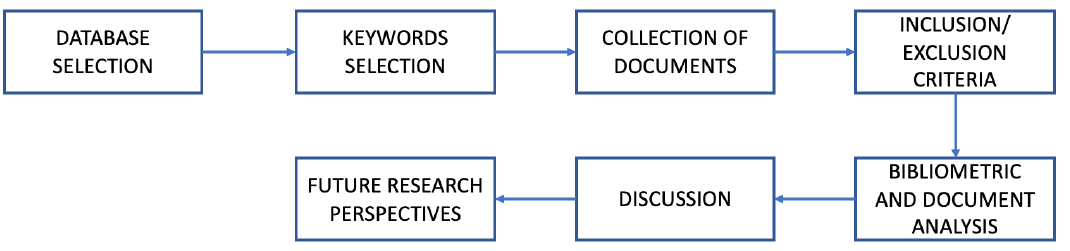
Figure 2. Seven-step procedure for literature review.